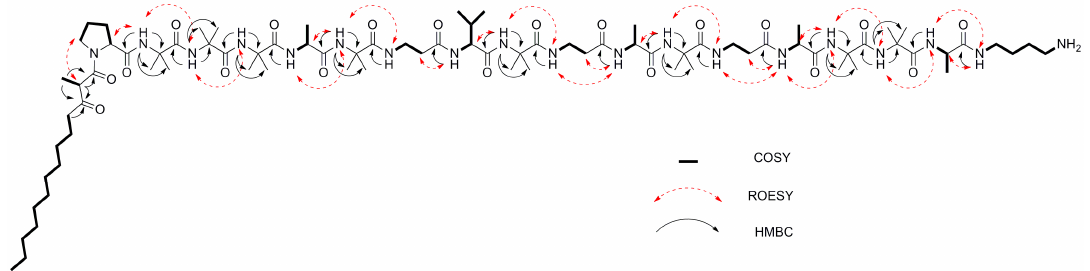
Figure 5. 2D NMR correlations used for structural characterization of compound 2.